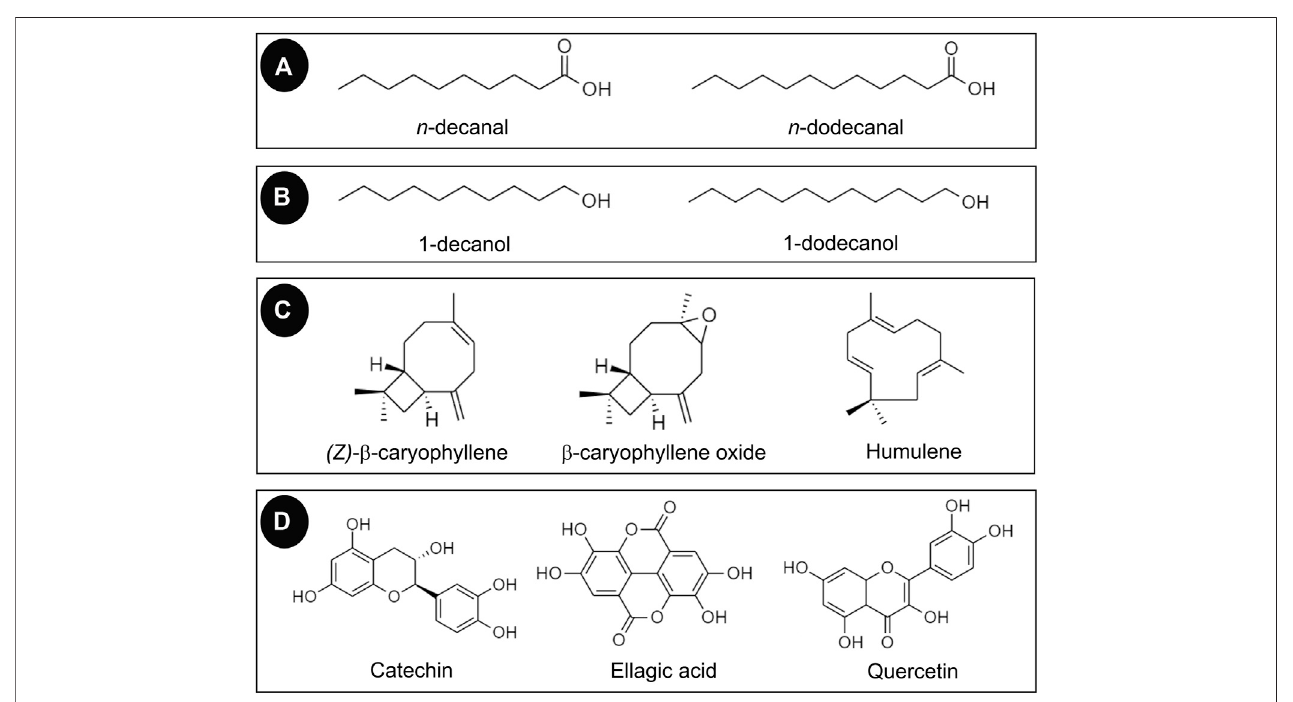
FIGURE 3 | Chemical constituents found in P. odoratum classi fi ed as (A) aldehydes, (B) alcohols, (C) terpenoids, and (D) fl avonoids and tannins.